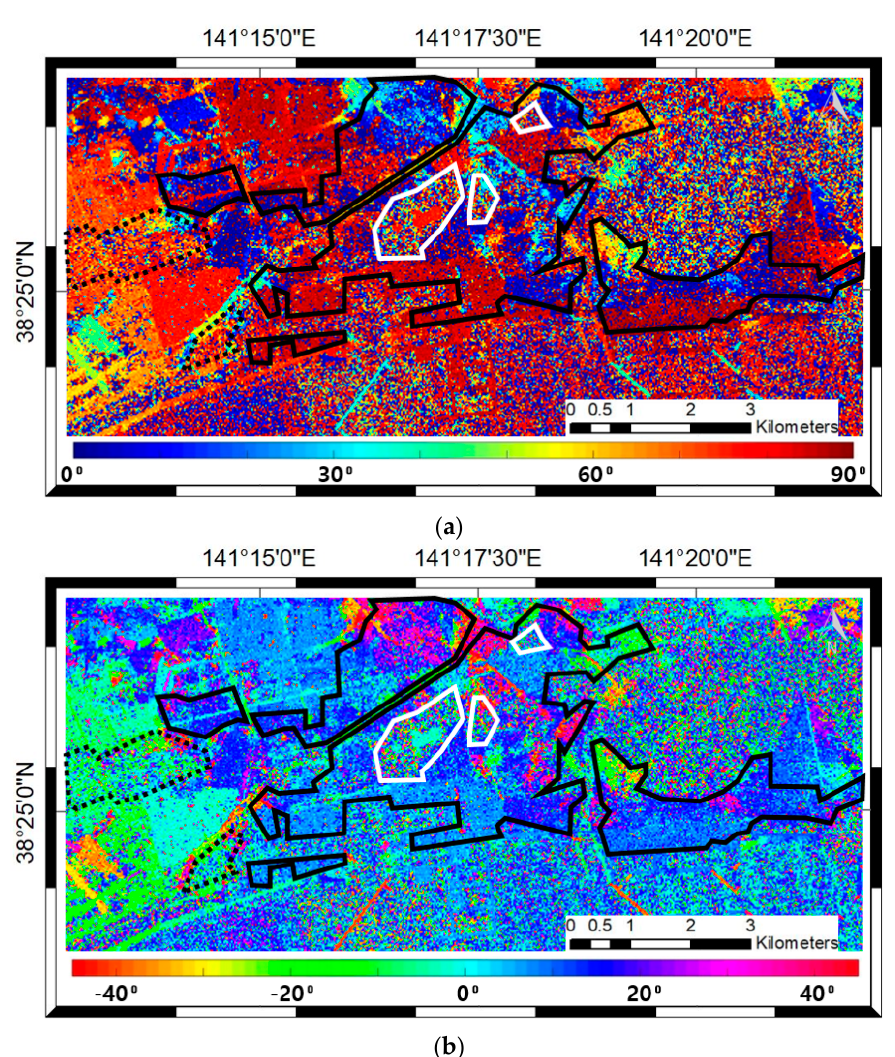
Figure 8. Results from the POA simulation step using KOMPSAT-2 data: ( a ) The estimated BOAs. The range of the BOAs is adjusted from 0° to 90° considering that the typical shape of urban buildings is rectangular; and ( b ) the simulated POAs with 23.836° of the incidence angle from post-tsunami ALOS/PALSAR-1 data and 20° of the azimuth direction angle to the North. The range of the simulated POAs is from − 45° to 45°. The densely built-up areas are highlighted with solid black lines, while the sparse built-up areas are highlighted with dotted black lines. The clouds are highlighted with white lines.